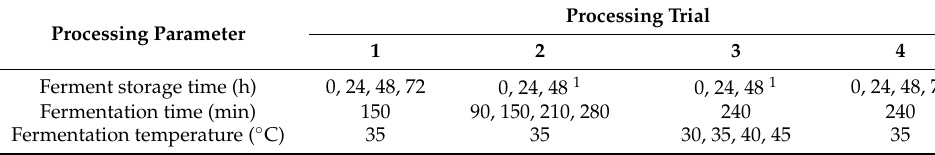
Table 3. Ferment processing trials.